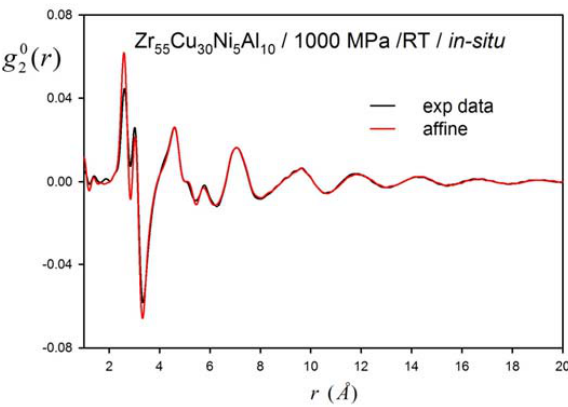
Figure 7. The anisotropic PDF, g 20 ( r ), determined during in situ experiment at 1000 MPa.